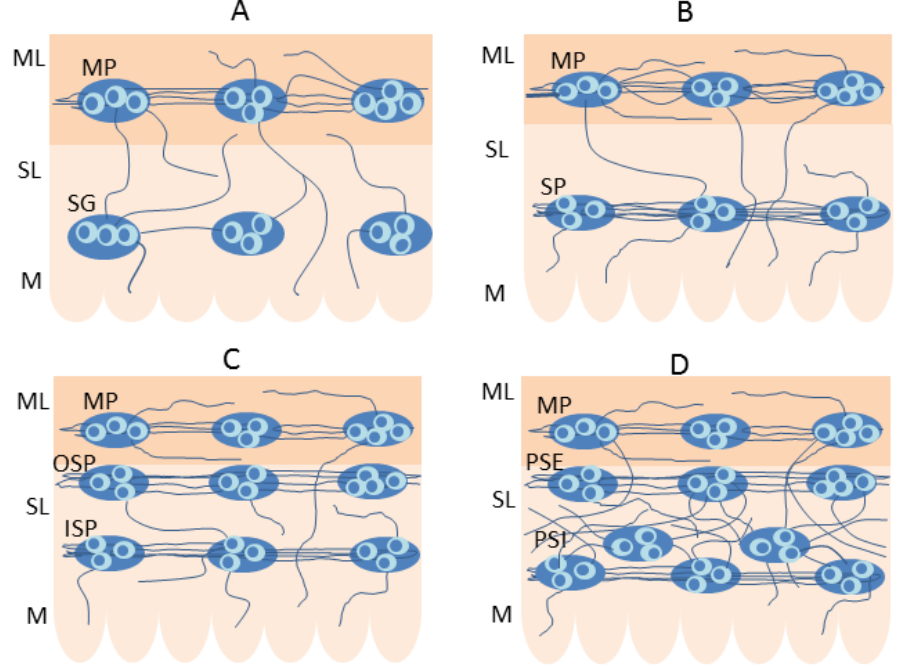
Figure 1. The organization of the enteric nervous system in various mammal species: A –oesophagus and stomach of the vast majority of mammal species, B –small and large intestine of rodents, C –small and large intestine of the domestic pig, D –human small and large intestine. ML = muscular layer, SL = submucosal layer, M = mucosal layer, MP = myenteric plexus, SG = submucous ganglia, SP = submucous plexus, OSP = outer submucous plexus, ISP = inner submucous plexus, PSE = plexus submucosus externus, PSI = plexus submucosus internus